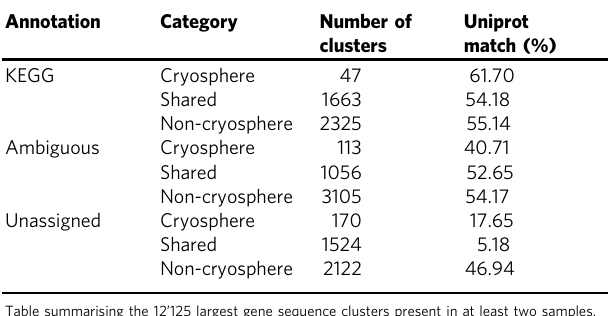
Table summarising the 12 ’ 125 largest gene sequence clusters present in at least two samples. The annotation refers to the assignment of the genes to one KEGG Orthologous group (KO), multiple KOs or unassigned (Ambiguous) and only unassigned (Unassigned). Distribution of assigned (KEGG), ambiguous and unassigned functional gene clusters highlighting the bias against cryospheric gene clusters. Shared refers to the representatives of both categories of samples contained gene sequences in the cluster. The number of clusters is shown, along with the proportion of clusters having a consensus sequence matching the UniProt